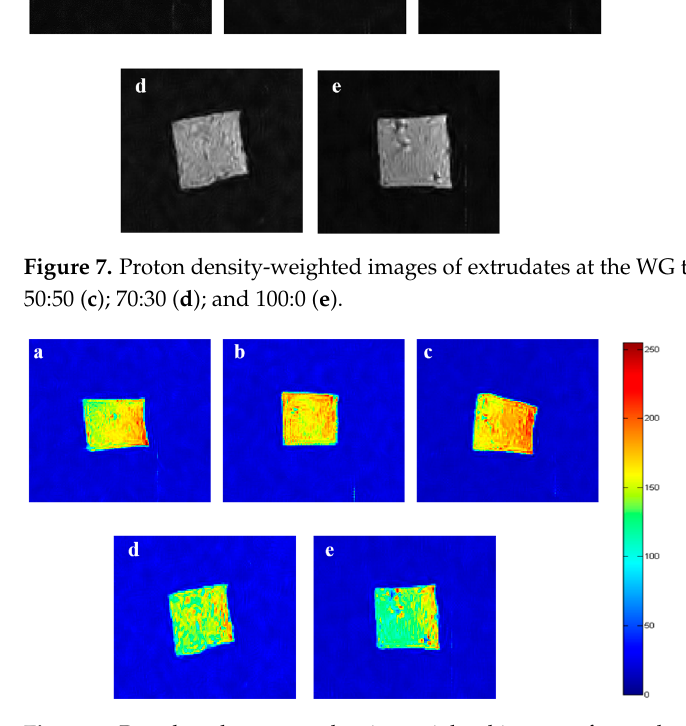
Figure 8. Pseudo-color proton density-weighted images of extrudates at the WG to PPP ratio of 0:100 ( a ); 30:70 ( b ); 50:50 ( c ); 70:30 ( d ); and 100:0 ( e ).